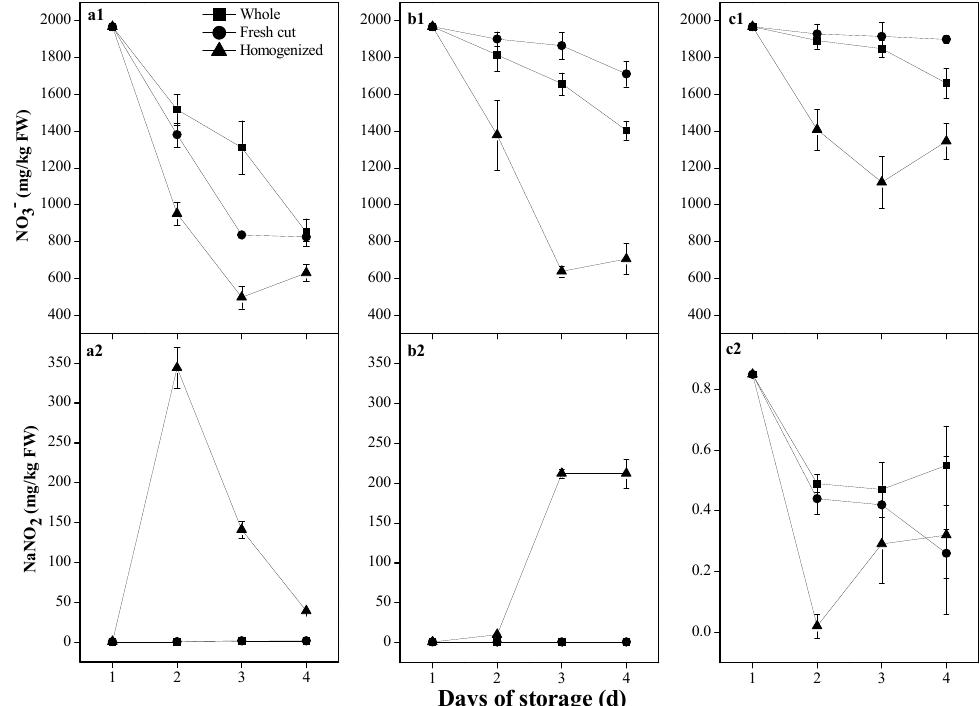
Figure 2. A laboratory test shows that the variations of nitrate and nitrite contents in the fresh celery ( Apium graveolens L.) in the whole, fresh-cut and homogenized forms stored at temperatures of 30 °C ( a1 , a2 ), 4 °C ( b1 , b2 ) and − 20 °C ( c1 , c2 ) for persistent four days.